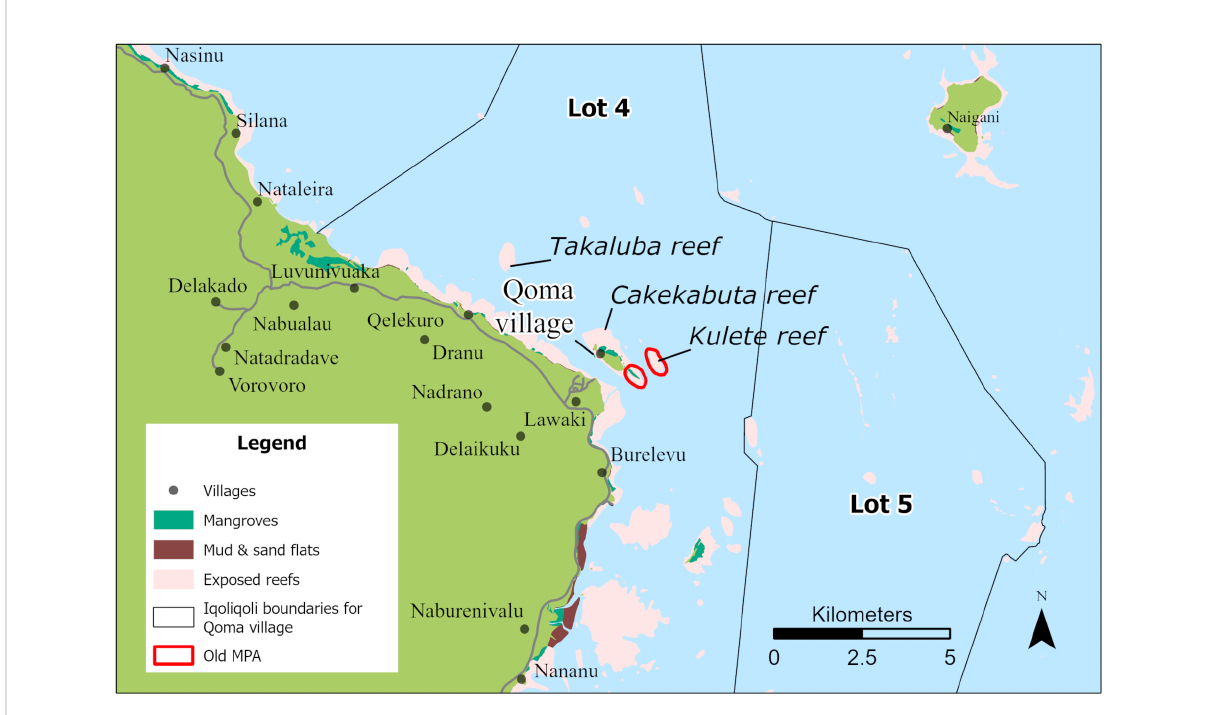
FIGURE 2 Qoma village with iqoliqoli boundaries and nearby marine habitats. The Lots labelled in these maps are the traditional fi shing boundaries allotted and marked out by the Native Lands and Fisheries Commission between 1958 – 1967 and the records are kept with the Ministry of iTaukei Affairs of fi